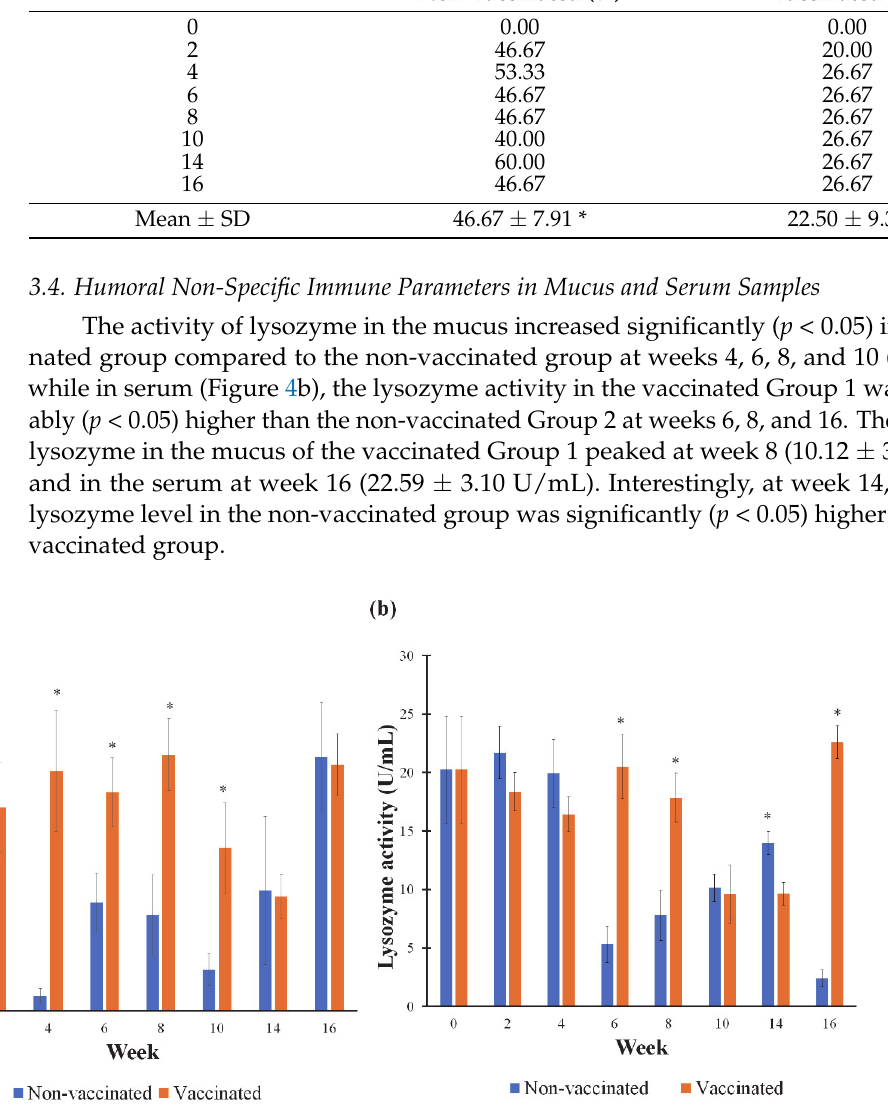
Figure 4. The activity of lysozyme in the mucus ( a ) and serum ( b ) following vaccination with feed- based inactivated V. harveyi strain VH1 vaccine. The non-vaccinated fish were given a commercial pellet formulated with PBS. Asterisks (*) indicate a significant difference at p < 0.05 between the vaccinated and non-vaccinated